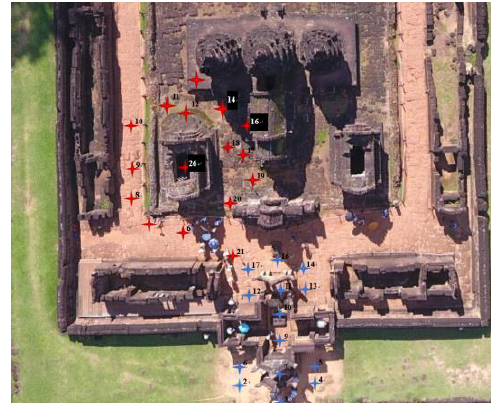
Figure 3. Field survey on 27-28 Sep. 2017